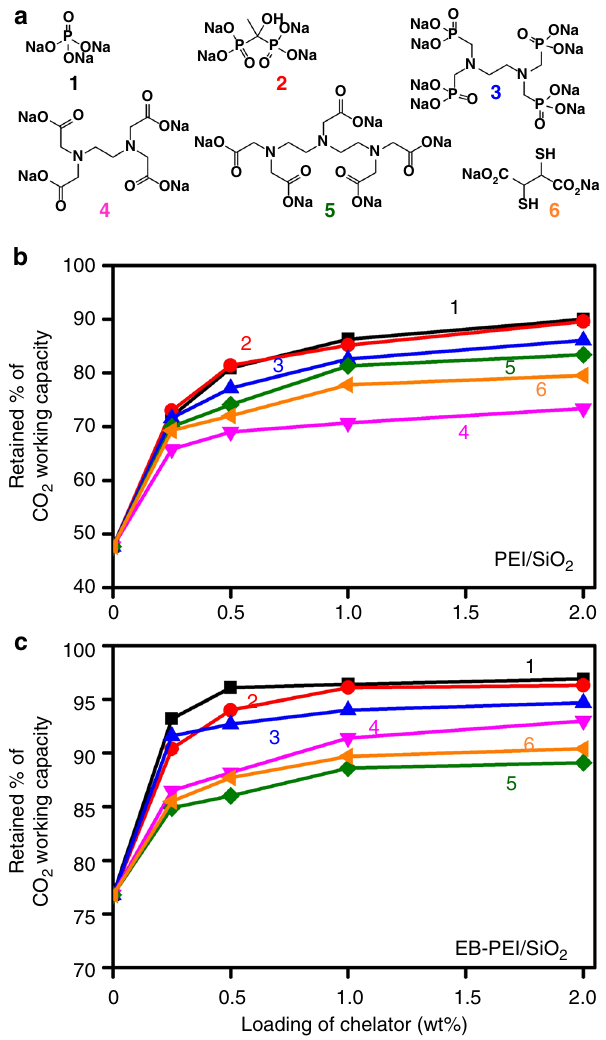
Fig. 3 Poisoning of metal impurities using chelators and its retardation effects on amine degradation. a Types of chelators. b , c Retained CO 2 working capacity (%) of PEI/SiO 2 ( b ) and EB-PEI/SiO 2 ( c ) containing different amounts of chelators after oxidative aging under 3% O 2 in N 2 at 110 °C for 1 day. The numbers on plots indicate the types of chelators shown in a